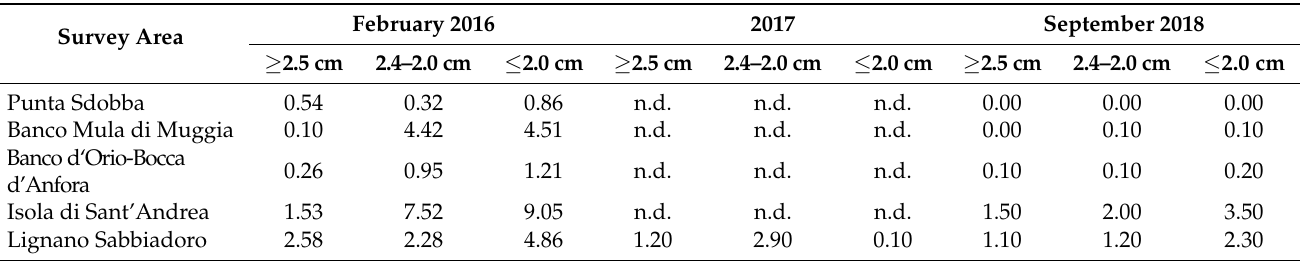
Table 5. Biomass (mean value; g/m 2 ) of Chamelea gallina (divided by size as shell total length; cm) recorded in February 2016 before the reactivation activities in 2017, again to register the resource to proceed with a reactivation, and in September 2018 for the monitoring of the resource following the sowing that occurred in previous years [73,116].